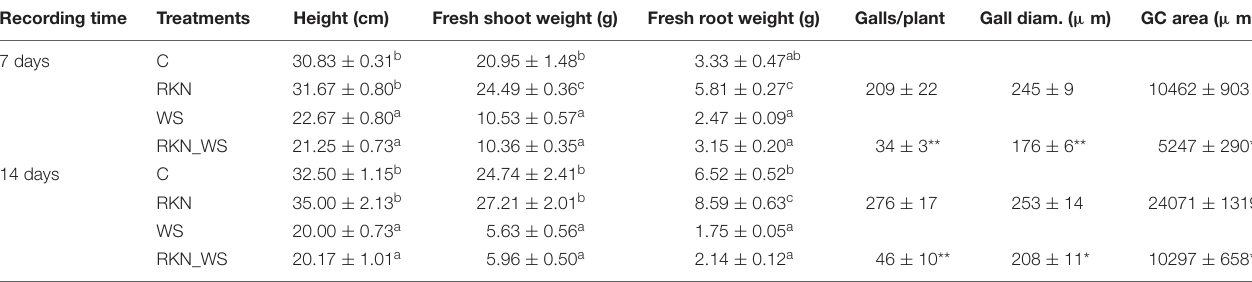
TABLE 1 | Effect of water stress on tomato vegetative growth and M. incognita infection. Recording time